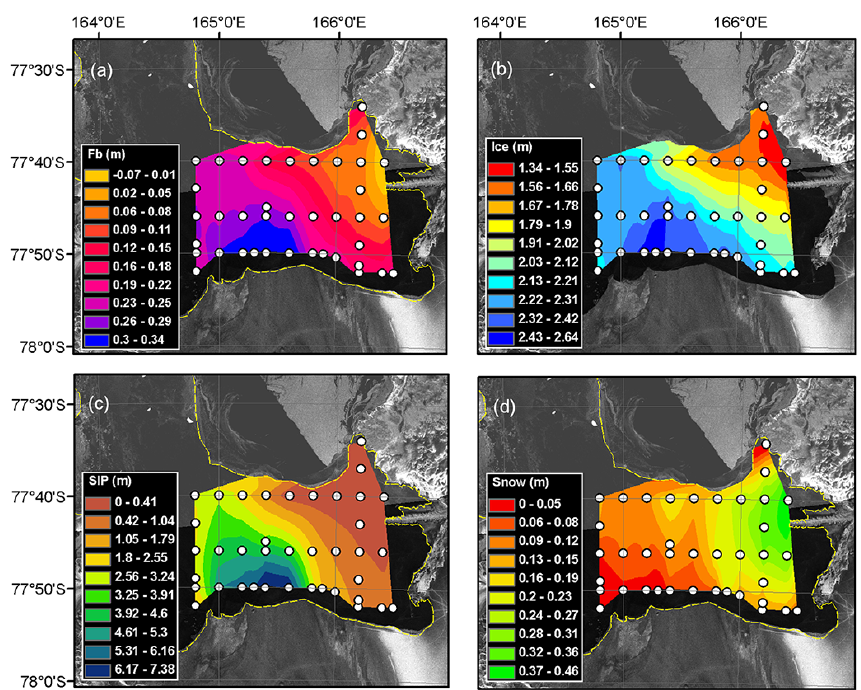
Figure 3. Interpolated maps of drill-hole measurements of (a) freeboard (b) ice thickness, (c) sub-ice platelet layer thickness (SIP) and (d) snow thickness of first-year sea ice in McMurdo Sound in November and December 2011. These are overlaid upon an Envisat ASAR mosaic composed of two images from 25 and 28 November.